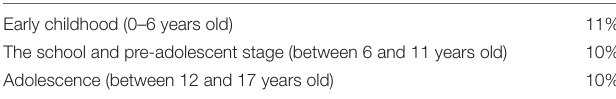
TABLE 1 | Distribution of children between 0 and 17 years